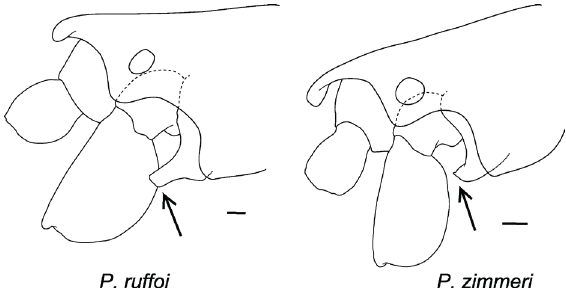
Figure 4 - Phoxocephalopsis ruffoi sp. nov. Female, 7.5 mm, MNRJ 22101, ensiform process truncate. Phoxocephalopsis zimmeri , Female, 7.0 mm, MNRJ 28874, ensiform process